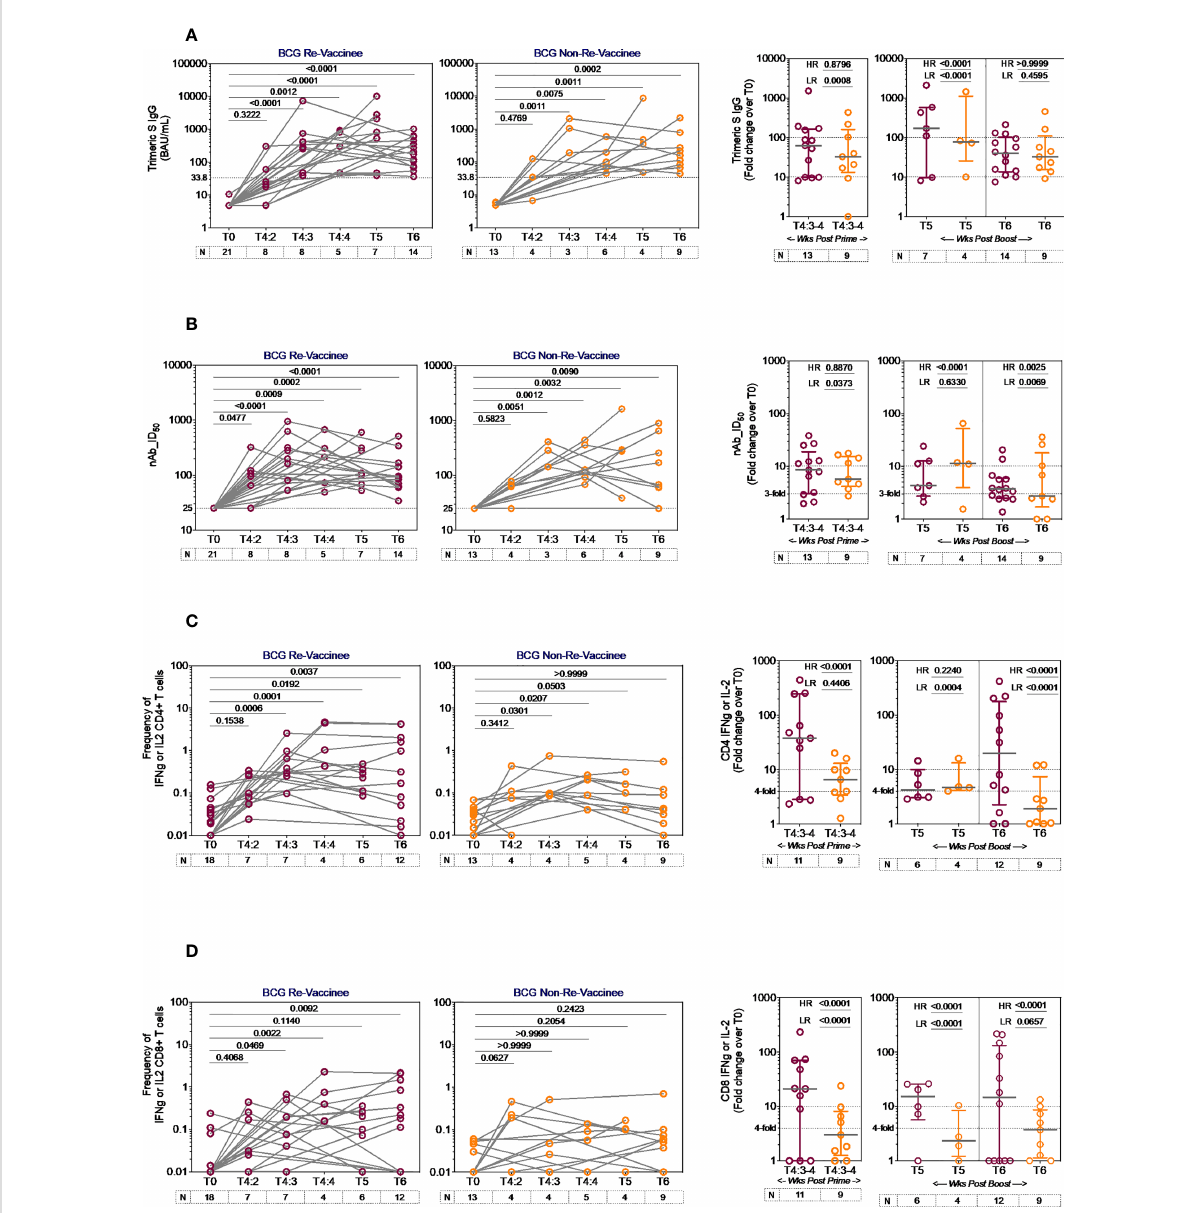
FIGURE 2 Kinetics of spike-speci fi c vaccine induced responses in BCG-RV and BCG-NRV. Longitudinal analysis of antibody and T cell responses in COVISHIELD ™ vaccinated BCG-RV (purple circles) and BCG-NRV (orange circles) subjects at baseline (T0), 2-, 3- and 4-weeks post-prime (T4:2, T4:3 and T4:4), 6-7 weeks post boost (T5) and 20-23 weeks post-boost (T6). (A) SARS-CoV-2 anti Spike protein IgG titres measured by LIAISON ® SARS-CoV-2 TrimericS IgG assay and (B) neutralizing antibody titres (nAb ID 50 ) in paired plasma samples. (C, D) PBMCs were stimulated with Spike peptide pool (0.06 nM) for 20 hr. CD4+ and CD8+ T cells were analyzed for intracellular expression of IFN- g or IL-2. Grouped scatter plot with median (horizontal grey line) and interquartile range comparing fold change in plasma antibody titres and frequencies of IFN- g or IL-2 CD4+ and CD8+ T cells over baseline or at 3-4 weeks post-prime (T4:3-4), 6-7 weeks post boost (T5) and 20-23 weeks post boost (T6). Statistical signi fi cance was determined by Kruskal-Wallis test with Dunn ’ s correction for line graphs and Wilcoxon matched paired t- test for scatter plots. The proportion of each group that showed a positive serologic response to Spike, neutralizing antibody titres or a positive IFN- g or IL-2 CD4+ and CD8+ T cell response to Spike were compared between COVISHIELD ™ vaccinated BCG-RV (purple circles) and BCG- NRV (orange circles) by using Fisher ’ s exact test. HR indicates the p-value for high-responders in each group (subjects with >100-fold change over baseline for TrimericS IgG, >10-fold change for nAb, CD4+ or CD8+ T-cell responses). LR indicates the p-value for low-responders (>10- fold change for TrimericS IgG, >3-fold change for nAb and >4-fold change for CD4 or CD8 T-cell